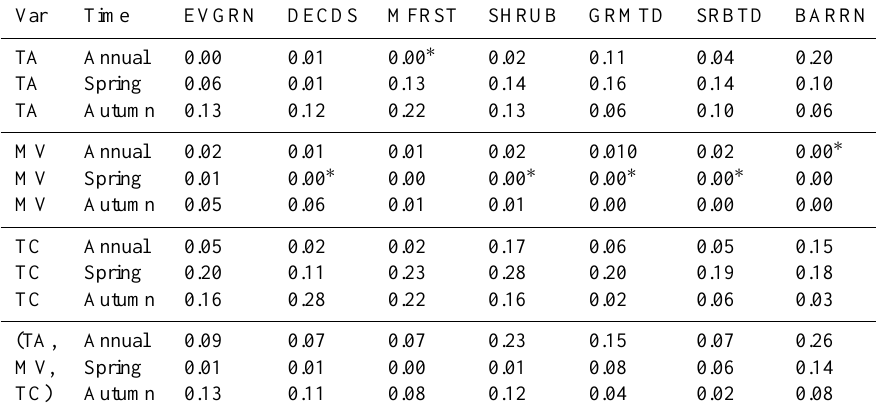
Table A1. R 2 values from the linear regressions of SWE and air temperature (TA), SWE and volumetric soil moisture (MV), and of SWE and vegetation transmissivity at 10.7GHz (TC). Comparisons of SWE and growing-season observations were conducted by comparing mean annual 2003–2008 values (mean), and by examining associations between SWE at the end of the snow season with growing-season variables at the start of the growing season (spring), and between growing-season variables at the end of the growing season with SWE at the start of the snow season (autumn). R 2 values in single linear regression that correspond to a p value > 0.01 are marked with an asterisk. Var